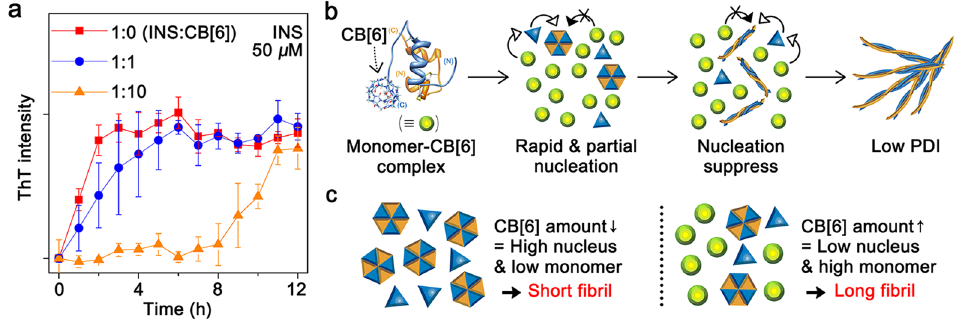
Figure 3. Fibrillation mechanism controlled by CB[6]. ( a ) Thioflavin T (ThT) assay for the kinetics of INS fibrillation with various amounts of CB[6] in solution (INS = 50 μ M). The 5 mM CB[6] condition was excluded because of the turbidity of CB[6] in the solution. ( b ) Schematic representation for CB[6]-mediated kinetic control in nucleation. ( c ) Correlation between fibril length and monomer:nucleus ratio. As the amount of CB[6] decreases (left) or increases (right), the fibril length is shortened or lengthened,